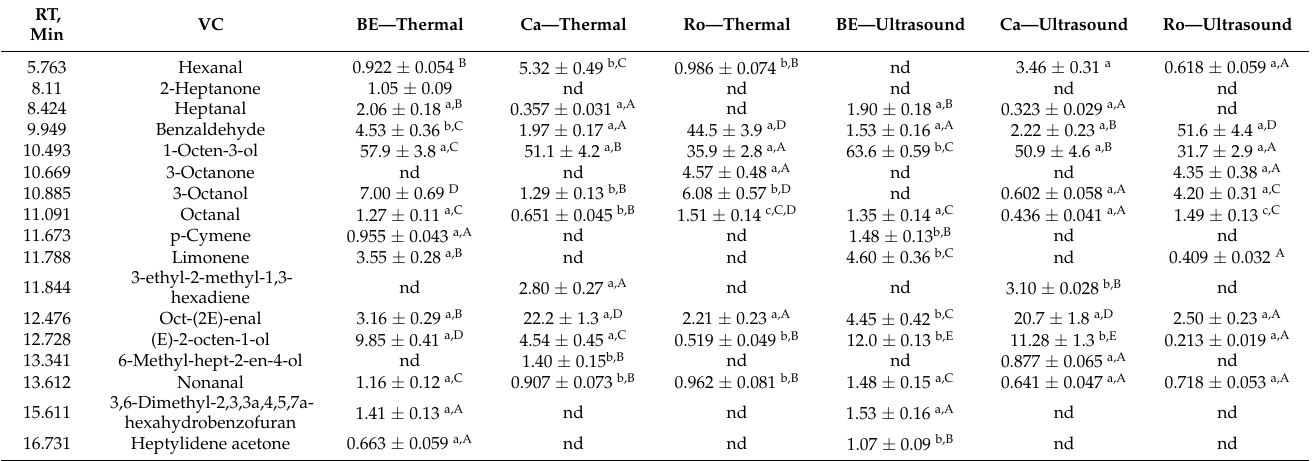
Table 3. Volatile compounds (in whole profile >1%) of thermal treated and ultrasonicated non- fermented mushrooms (% from the total volatile